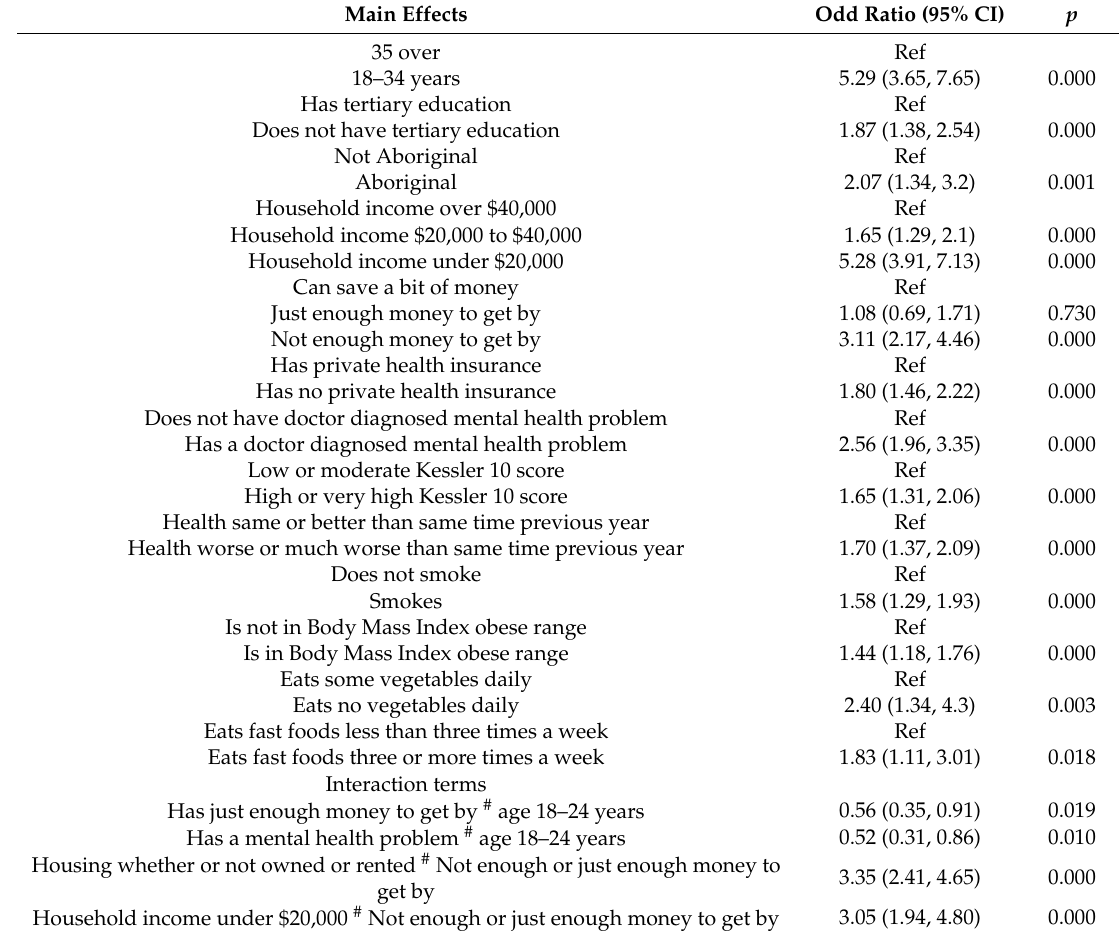
Table 2. Weighted multivariable logistic regression for associations with running out of food including interaction terms, HWSS 2009–2013 (n = 17,638 a ) b